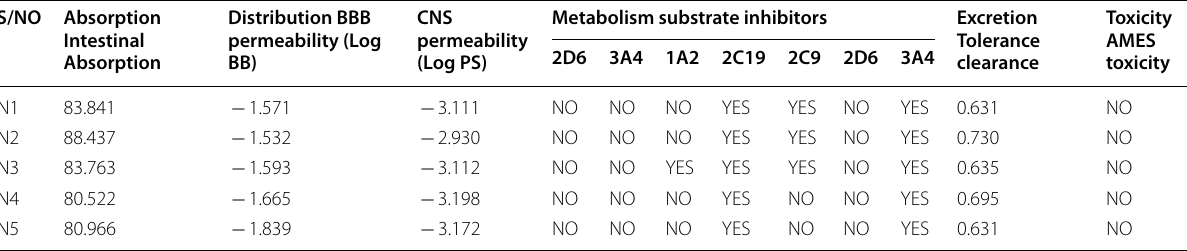
Table 7 Predicted ADMET properties of the designed compounds S/NO Absorption Intestinal Absorption